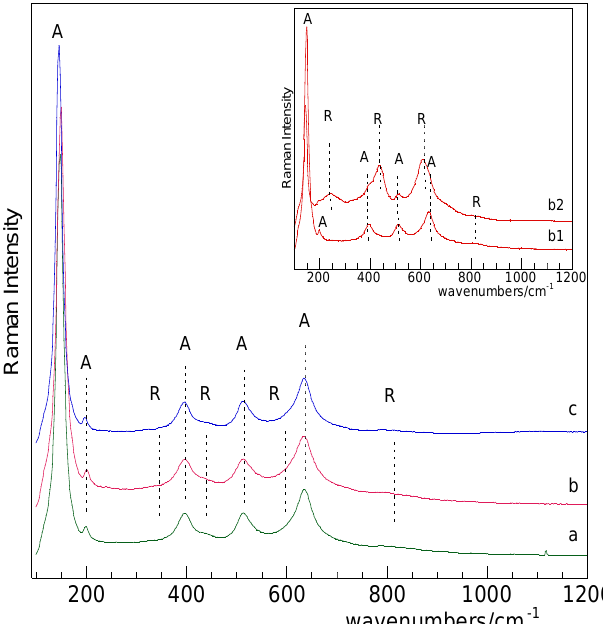
Figure 2. Representative Raman spectra of the Cu / P25 samples: ( a ) 1.0ICu / P25; ( b ) 1.0DCu / P25. And